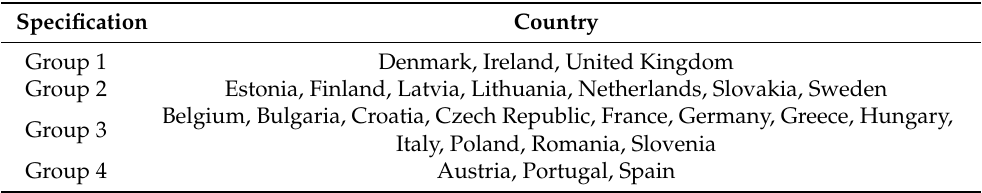
Table 6. Groups of EU Member States similar in terms of achievement of energy policy targets as of 2019.